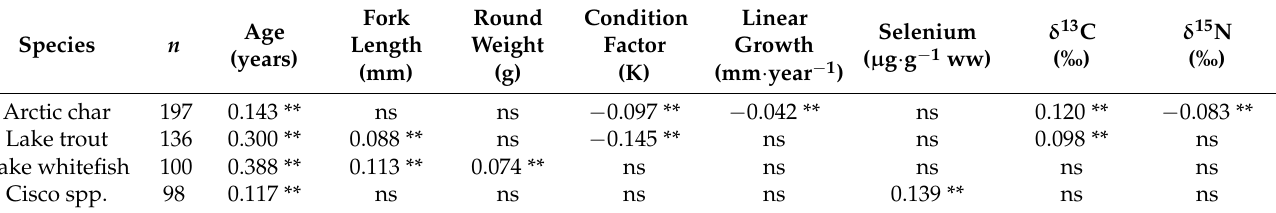
Table 3. Coefficient of determination (r 2 ) showing the proportion of variation in total muscle mercury (THg) concentrations in relation to age, fork length, body weight, condition, and linear growth, as well as soft tissue concentrations of selenium and stable carbon and nitrogen isotope ratios with statistical significance of the regressions, noting that negative relationships are indicated by minus